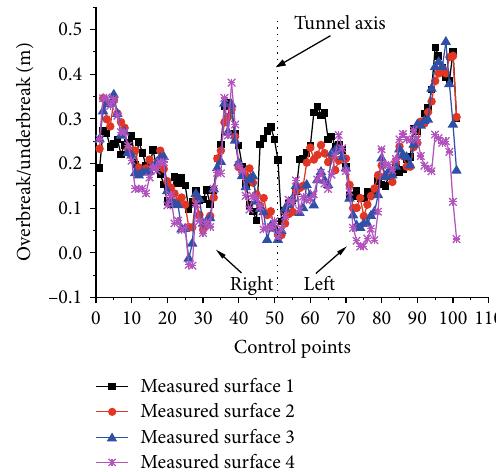
Figure 13: Comparison of the overbreak and underbreak control points.